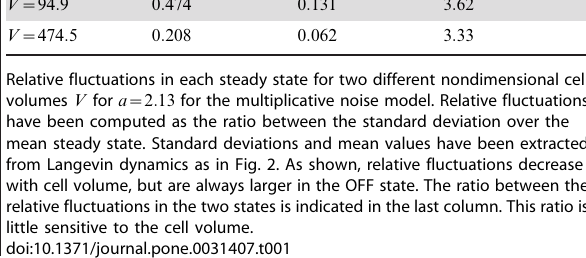
states is mantained at larger volumes.